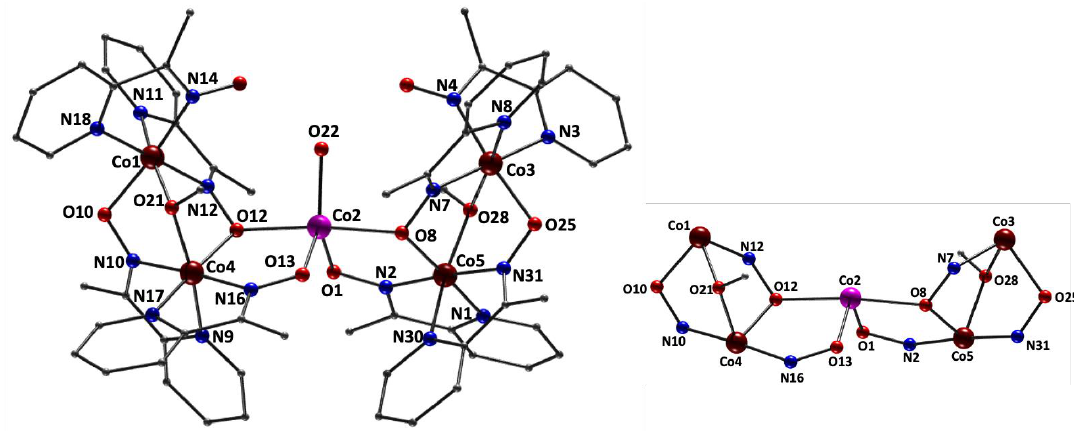
Figure 1. Representation of the molecular structure of 1 . Colour code: Ni, green; N, blue; O, red; C, grey.